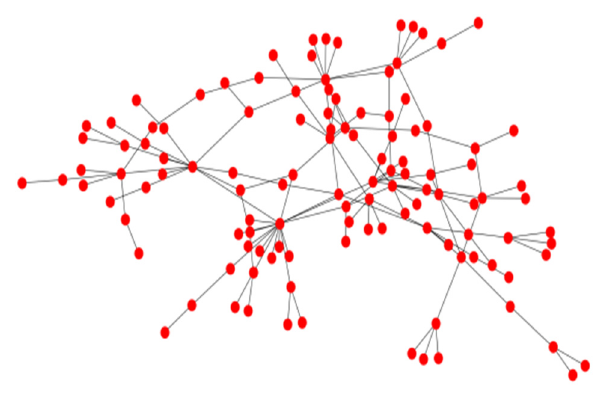
Figure 6. N = 118, m 0 = 3, m = 2 BA cyber network.